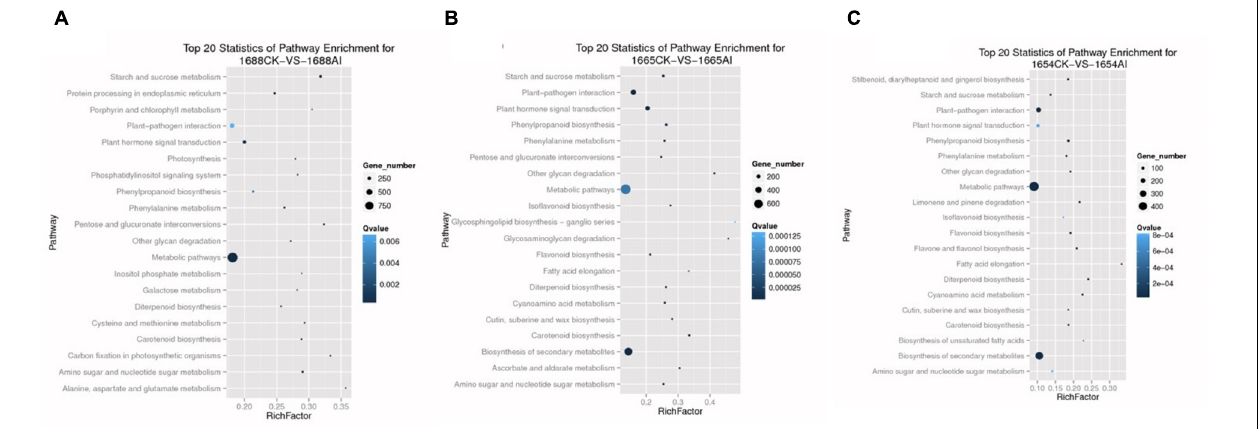
FIGURE 3 | Top 20 statistics of pathway enrichment for each group: (A) 1688CK-vs-1688AI; (B) 1665CK-vs-1665AI; (C) 1654CK-vs-1654AI. (Vertical axis represents the name of the pathway, while the horizontal axis represents the rich factor. The greater the rich factor, the greater the degree of enrichment. The size of the point indicates the number of DEGs in this pathway, and the color of the points corresponds to different Q -value ranges. The values of Q were between 0 and 1. The closer the Q -value is to zero, the more significant the enrichment).